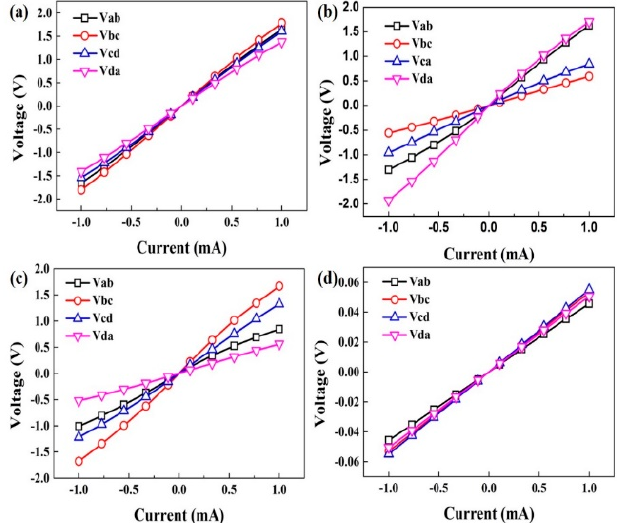
Figure 5. Electrical stability with I-V curve of all samples: ( a ) pristine CNW; ( b ) MWCNT (30 µ L) / CNW; ( c ) MWCNT (50 µ L) / CNW; ( d ) MWCNT (70 µ L) / CNW.